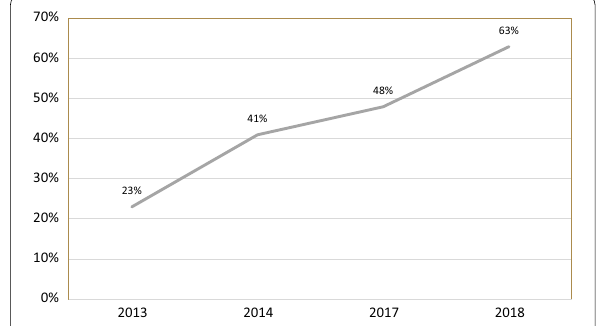
Fig. 3 Percent of cohort gaining at least 7 points on DO